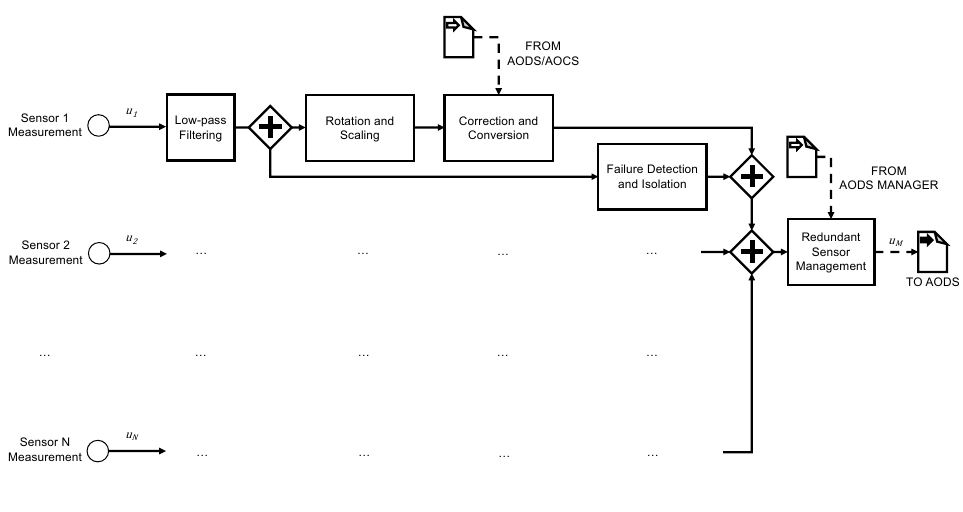
Figure 2. Sensor post processing